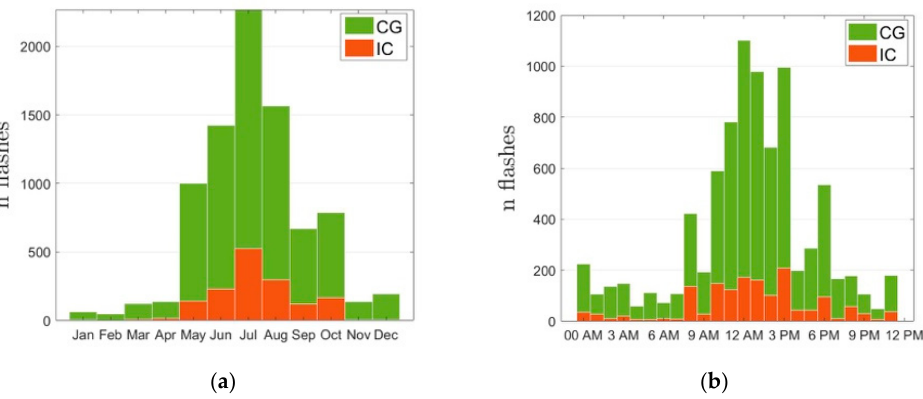
Figure 5. LINET daily ( a ) and annual ( b ) lightning distributions. Area considered: 5 km radius around the Mt. Cimone Observatory. Data range: 2012–2020.